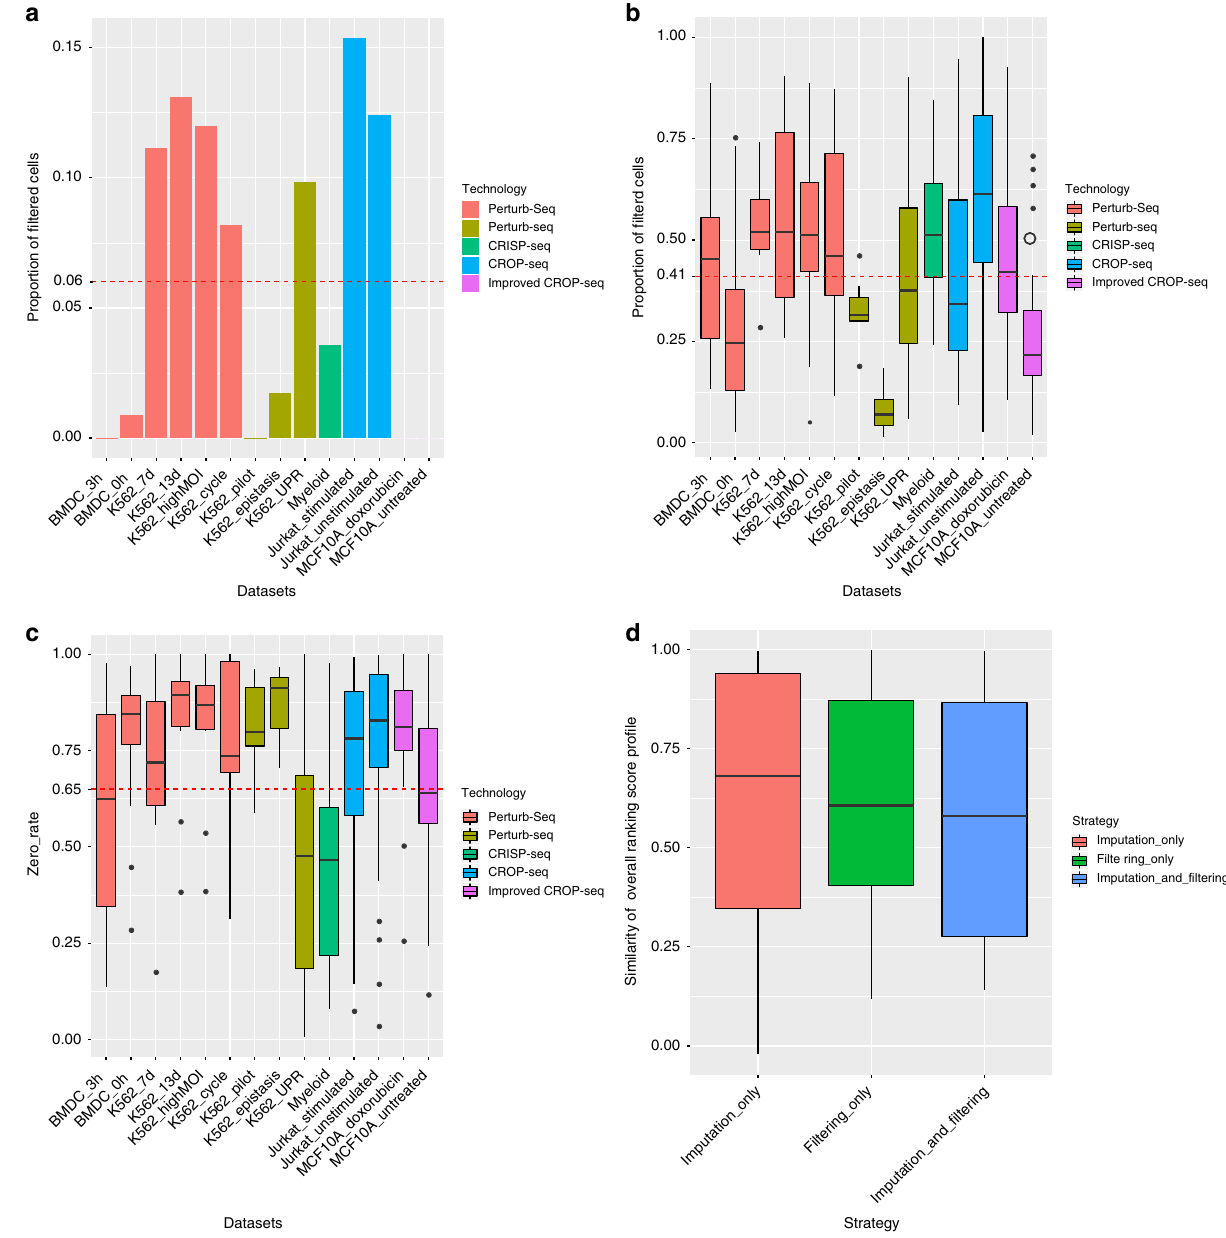
Fig. 4 Evaluating the impact of the data preprocessing strategies adopted in MUSIC. a The proportion of fi ltered cells by quality control for all datasets. The red dash line represents the mean of the data. b The proportion of fi ltered cells by fi ltering low ef fi ciency sgRNA for all datasets. The red dash line represents the mean of the data. c zero_rate plot of all knockouts/knockdowns in all datasets. The red dash line represents the mean value of all the knockouts/knockdowns zero_rates. d Comparisons of overall perturbation effect ranking with or without imputation/ fi ltering for all the available